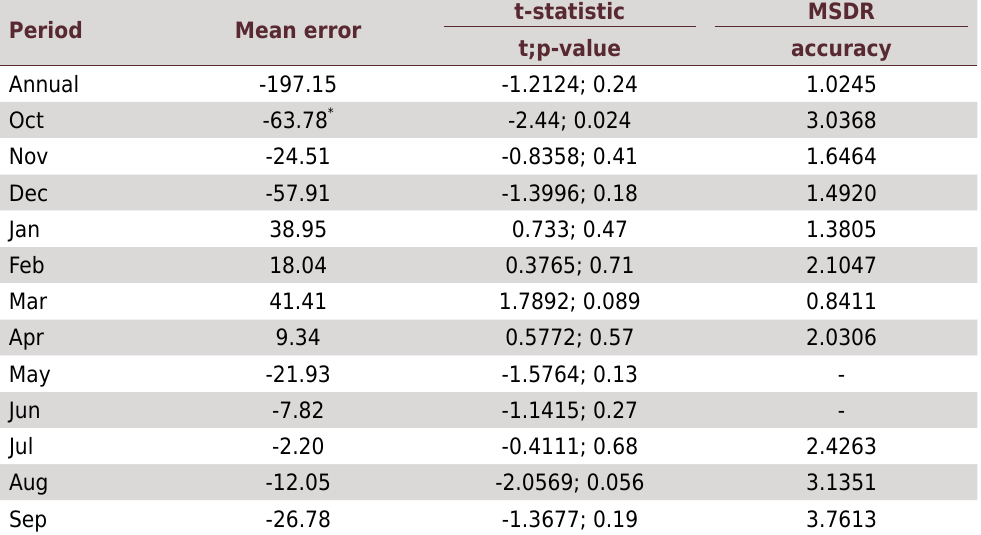
Table 4. Validation results